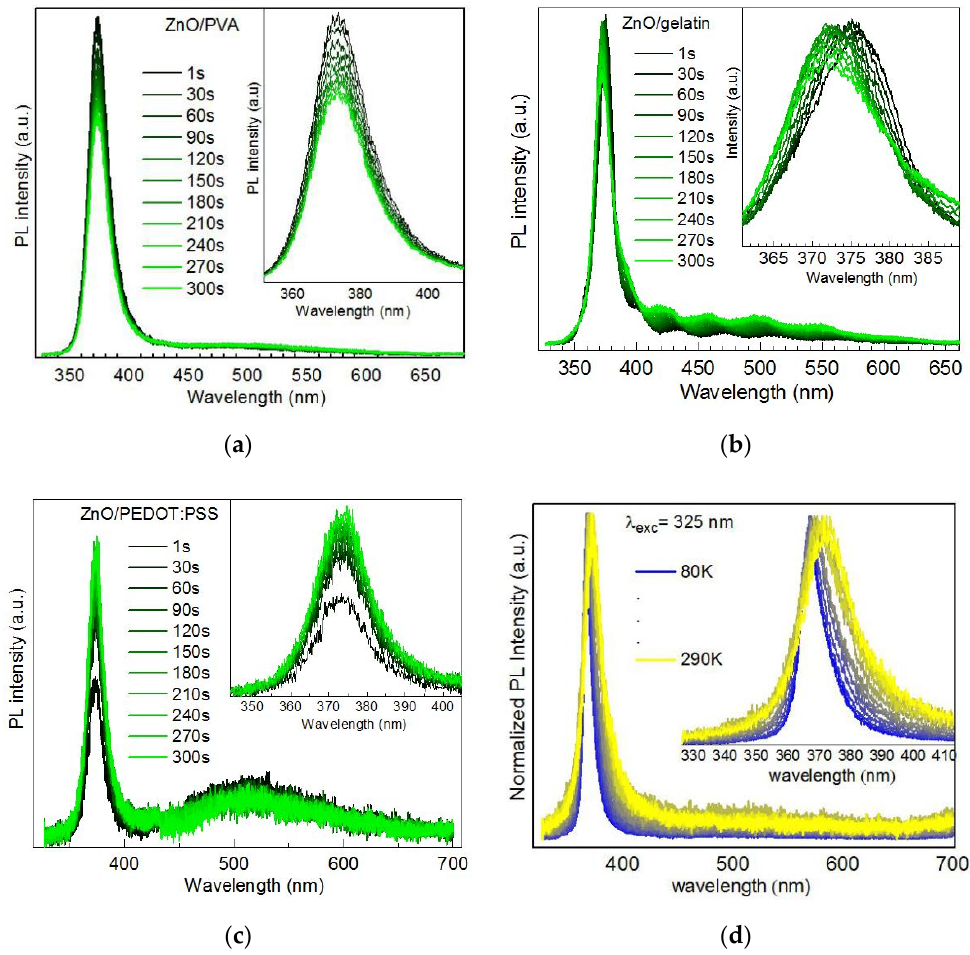
Figure 11. Evolution of the room-temperature PL spectra ( λ exc = 325 nm, 0.1 W/cm 2 ) of ZnO NCs in a matrix of PVA ( a ), gelatin ( b ), and PEDOT:PSS ( c ). The temperature dependence of PL of ZnO NCs in PEDOT:PSS is shown in ( d ). The waviness of the PL curve in ( b ) is due to interference in the polymer film.